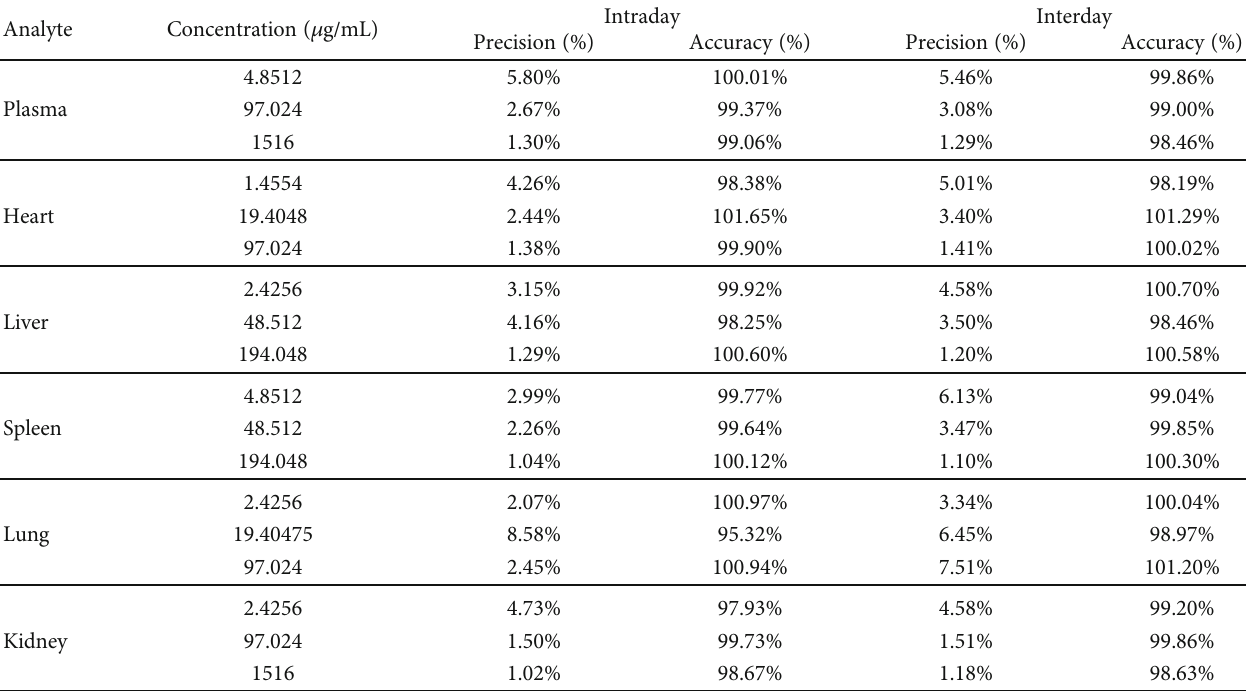
Table 2: The results of intraday and interday precision and accuracy for BA in blank plasma and tissues ( n = 5 for intra-day and n = 5 ∗ 3 for